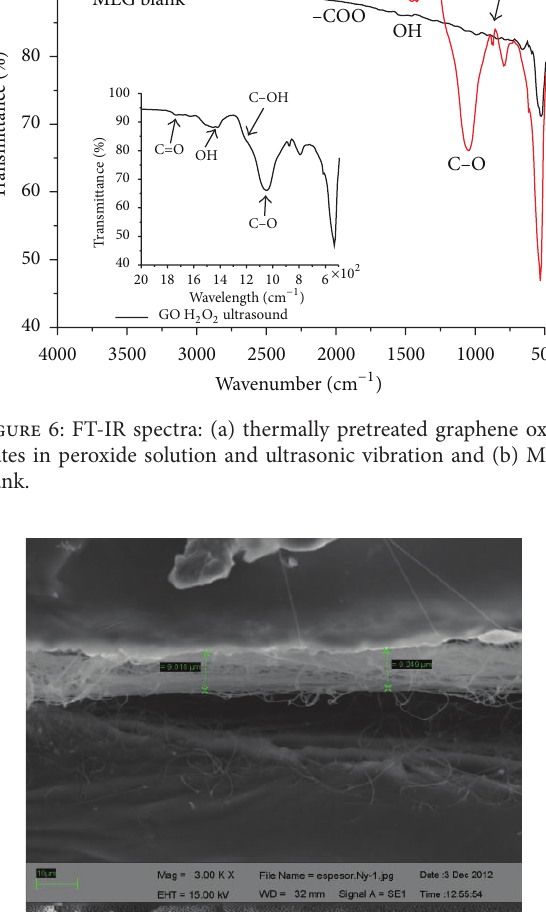
Figure 7: Ny/GO fibre film thickness formed after three hours of